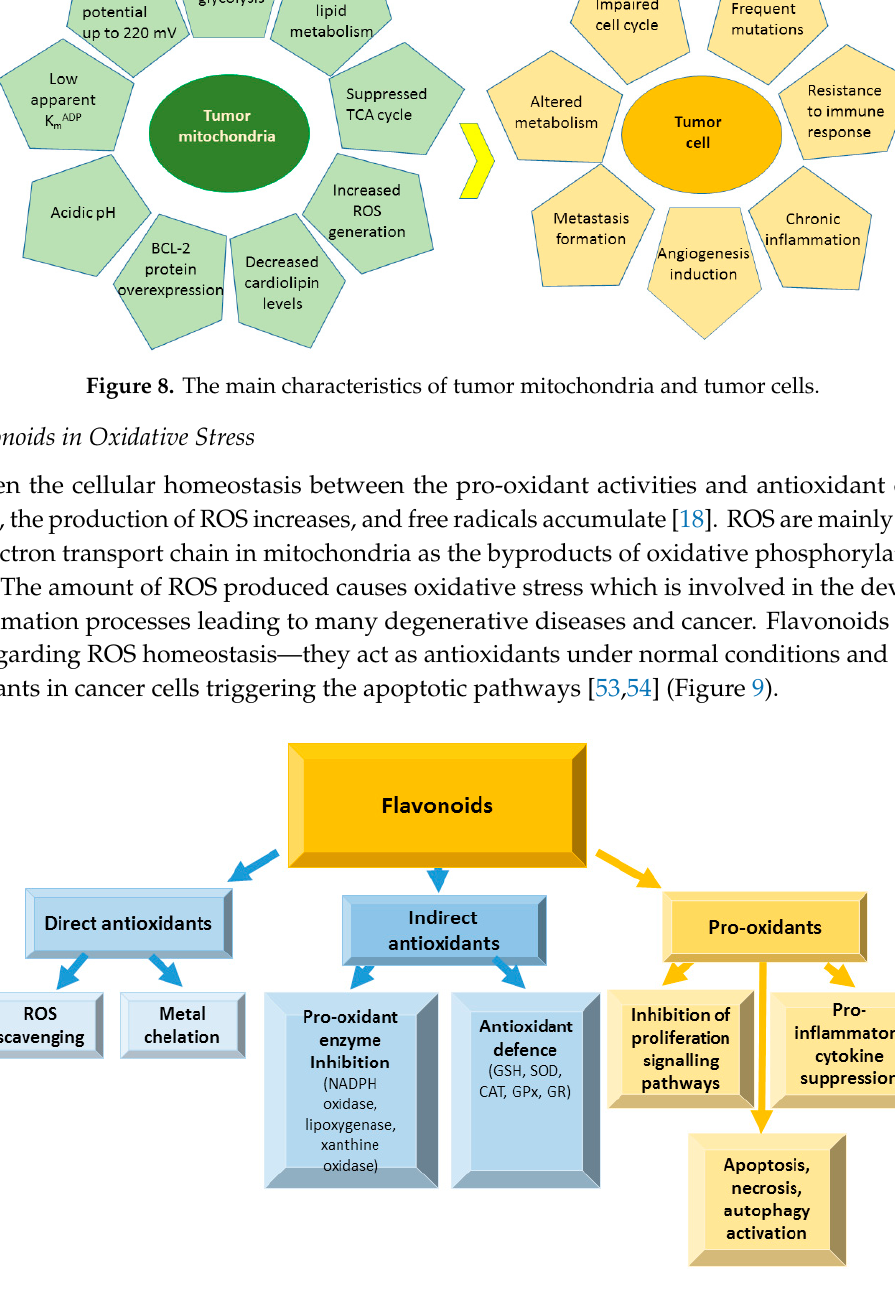
Figure 9. Antioxidant and pro-oxidant activities of flavonoids in oxidative stress. ROS—reactive oxygen species, NADPH-oxidase—nicotinamide adenine dinucleotide phosphate oxidase, GSH—glutathione, SOD—superoxide dismutase, CAT—catalase, GPx—glutathione peroxidase, GR—glutathione reductase.